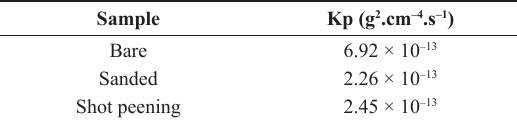
Table 4. Results of parabolic rate constant (Kp) by oxidation test.